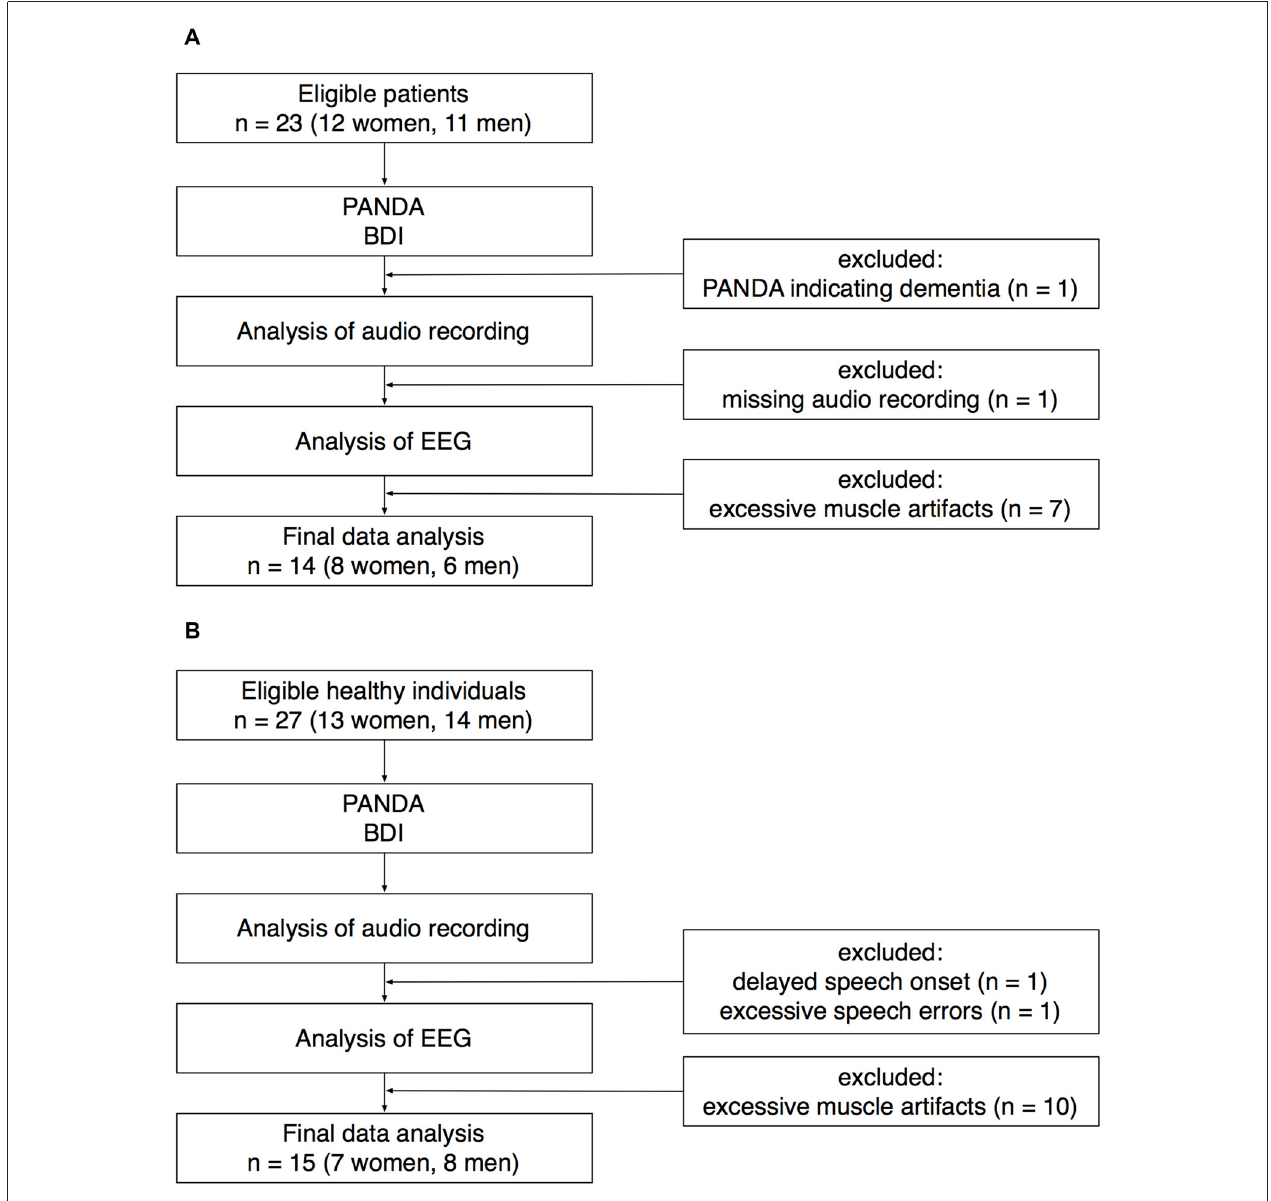
FIGURE 1 | Recruitment of patients (A) and healthy controls (B) . PANDA, Parkinson Neuropsychometric Dementia Assessment. BDI, Beck Depression